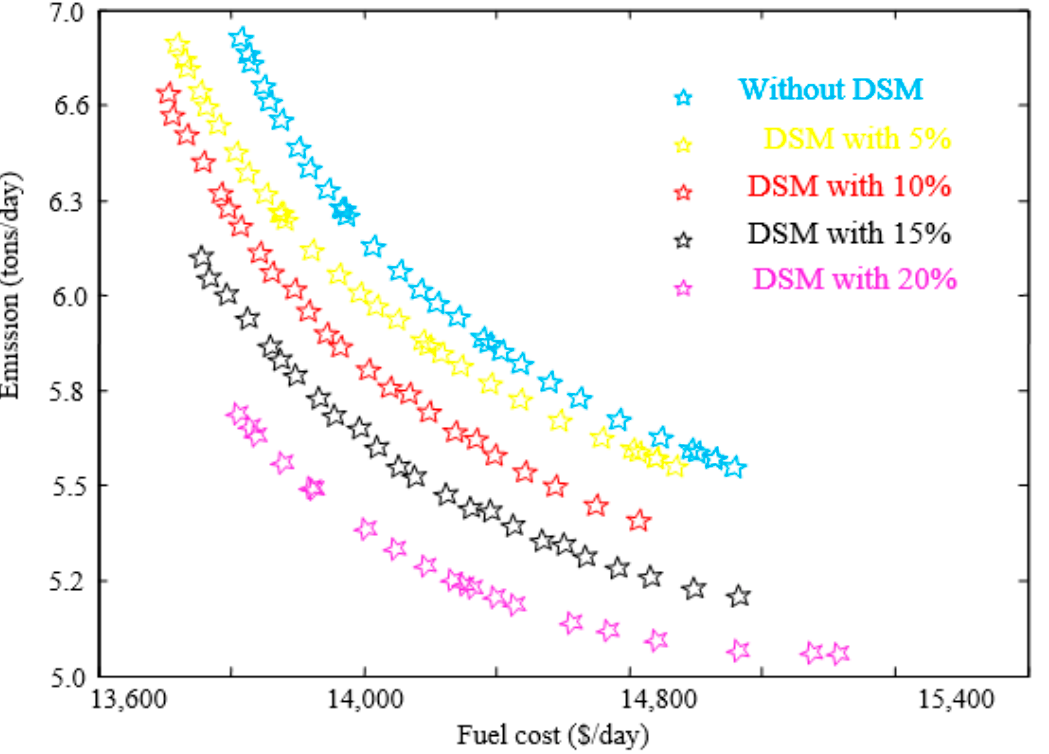
Figure 9. Dynamic economic and emission dispatch by various levels of DSM participation.